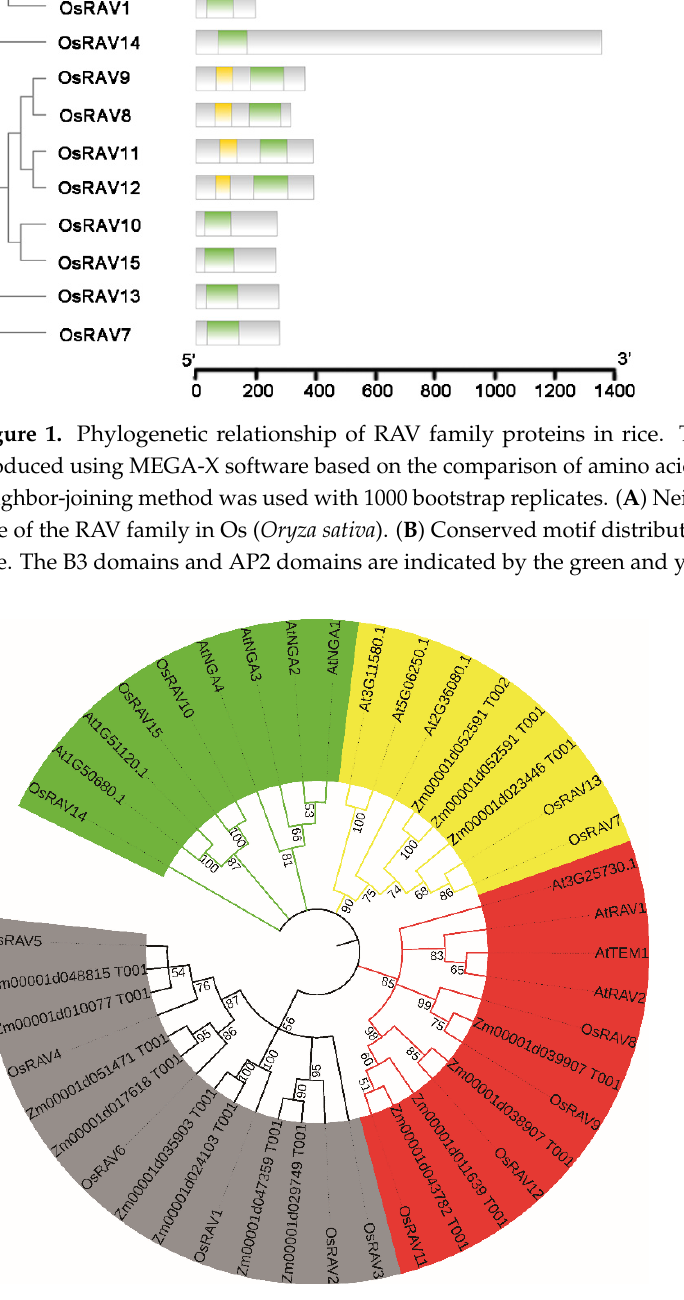
Figure 2. Phylogenetic relationship of the RAV families of At ( Arabidopsis thaliana ), Os ( Oryza sativa ), and maize ( Zea mays ).The four colors represent four different groups of the RAV family.